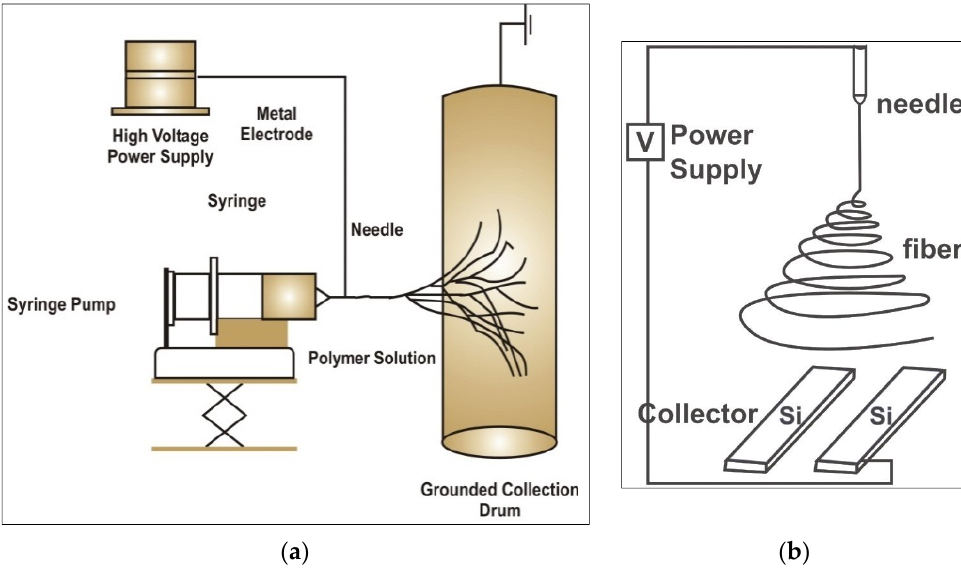
Figure 1. Schematic presentation of electrospinning process ( a ) a typical electrospinning equipment and its components ( b ) modifications of collector for aligning electrospun nanofibers.